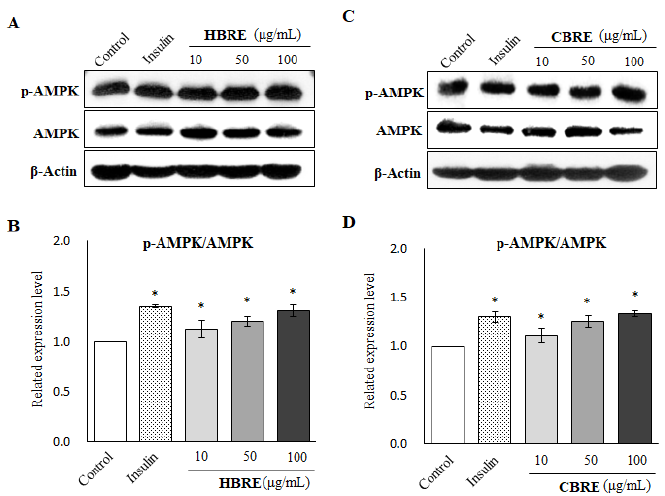
Figure 5. Effect of black rice extracts on AMPK signaling in C2C12 myotubes. Cells were treated with indicated concentrations of ( A , B ) HBRE and ( C , D ) CBRE for 24 h, and the representative immunoblot and quantification graphs were presented (means ± SD). * p < 0.05 vs. control group.